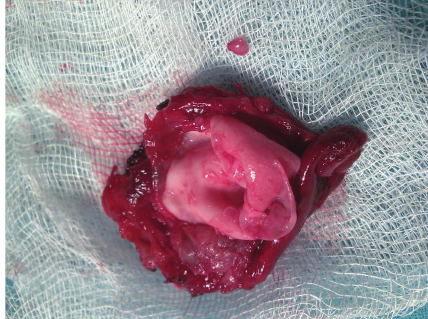
Figure 2: Removed thyroid right lobe and isthmus which includes a 30mm cystic nodule in the right thyroid lobe contained germinate membrane and daughter vesicles.